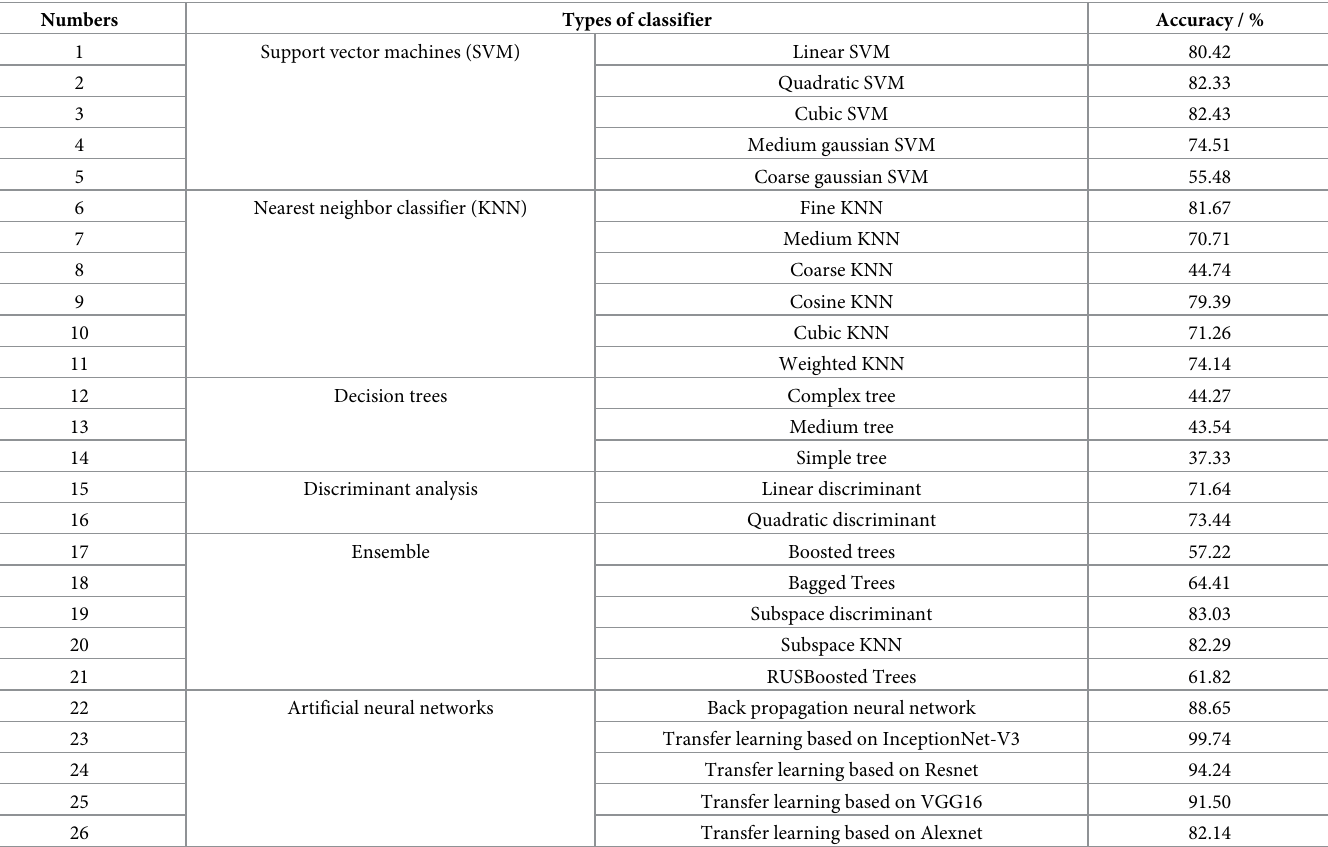
Table 7. Accuracy of classification results of different